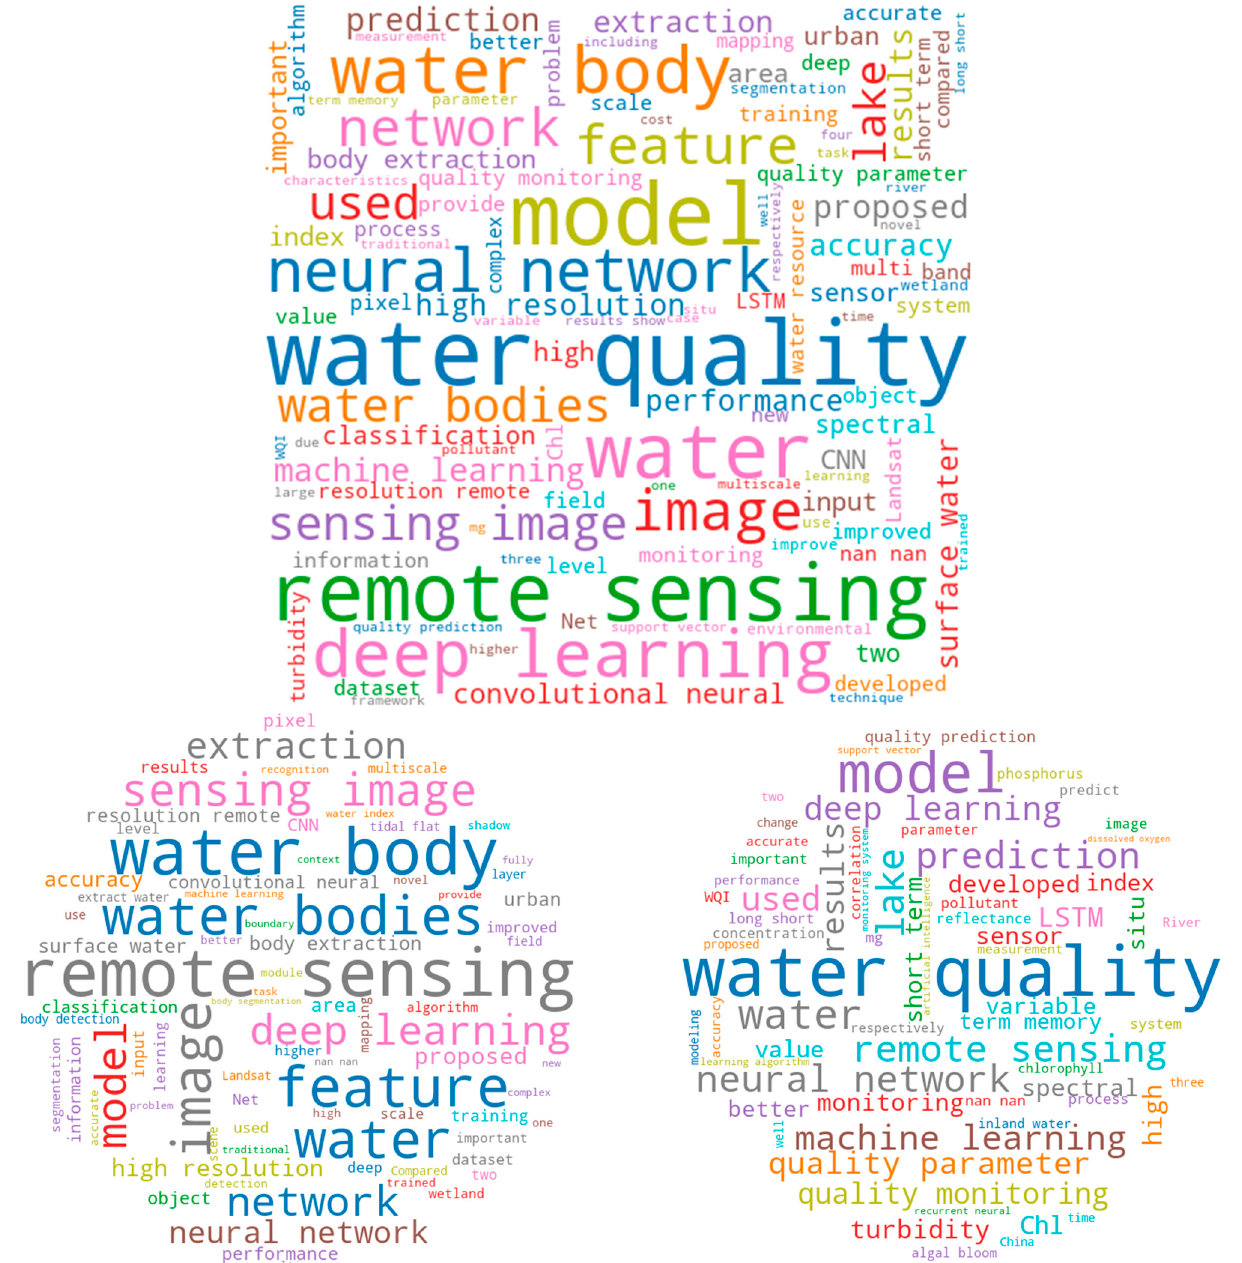
Figure 2. Word cloud visualization of all the reviewed papers ( top ), water body papers ( bottom left ), and water quality papers ( bottom right ). Note that the word clouds are generated from paper titles, abstracts, and keywords. The word clouds provide an informative (general and specific) focus of each set of the papers. For example, both water body and water quality papers share the focus on RS, DL, and neural networks (NN). We can also see that water body extraction tasks tend to focus on the use of convolutional neural networks (CNN), whereas for water quality modeling the use of long short-term memory (LSTM) networks is more prevalent. We can also see that there are specific, unique keywords for water quality, such as “turbidity”, “chl”, and “algal